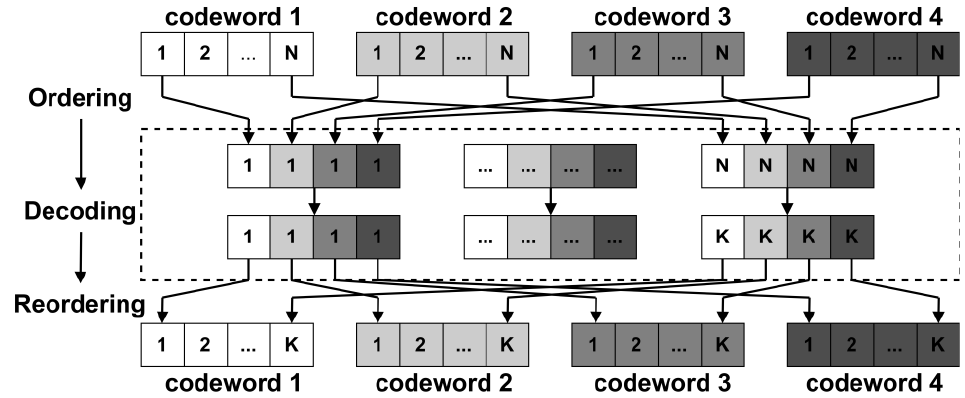
Figure 3. Schematic diagram of the ordering and reordering operations.